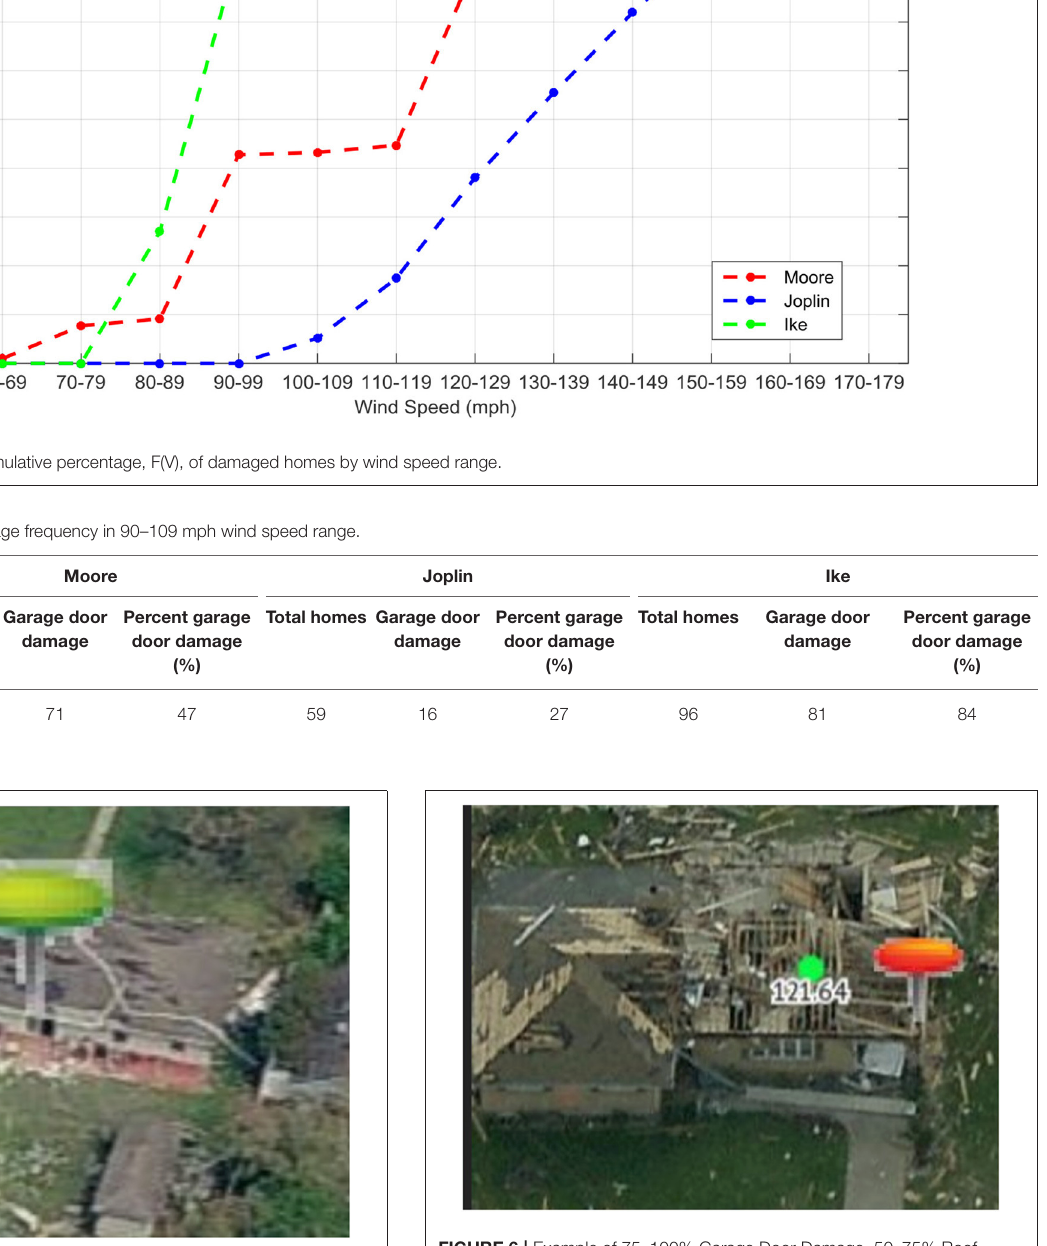
FIGURE 6 | Example of 75–100% Garage Door Damage, 50–75% Roof Structural Damage. Image resolution and quality reduced for publication. Image courtesy of Eagleview Technologies,